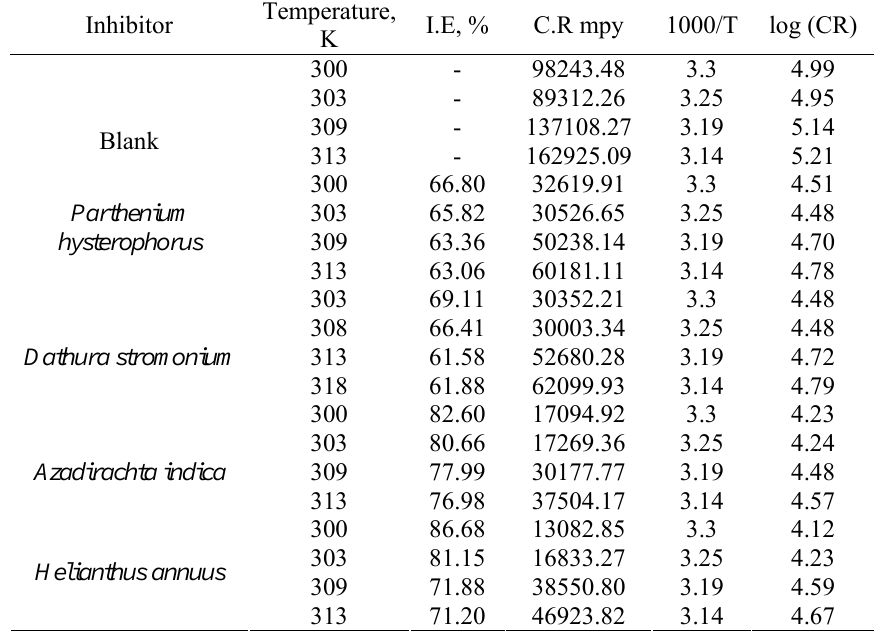
Table 2. Corrosion inhibition behaviour of mild steel in 1.5 N sulphuric acid solution in absence and presence of plant biomaterial by weight loss measurement